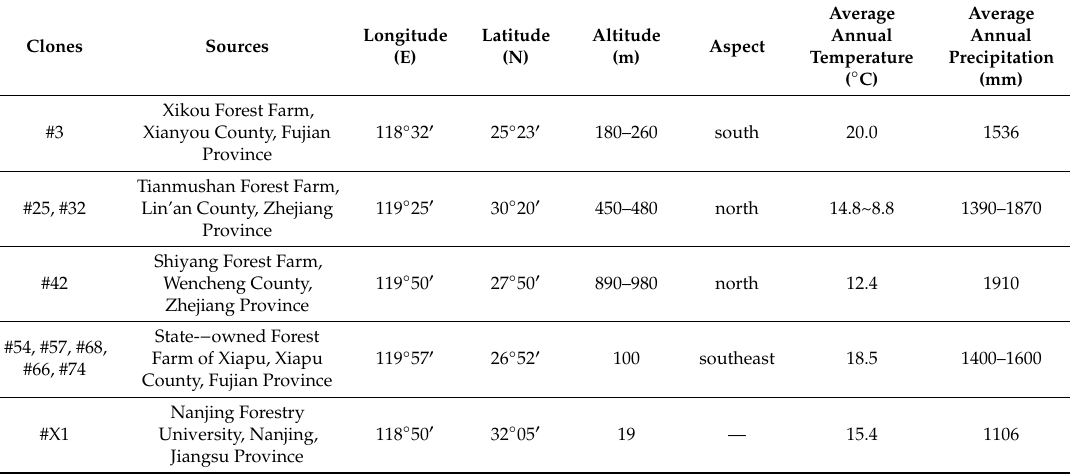
Table 1. The geographic location of C. fortunei